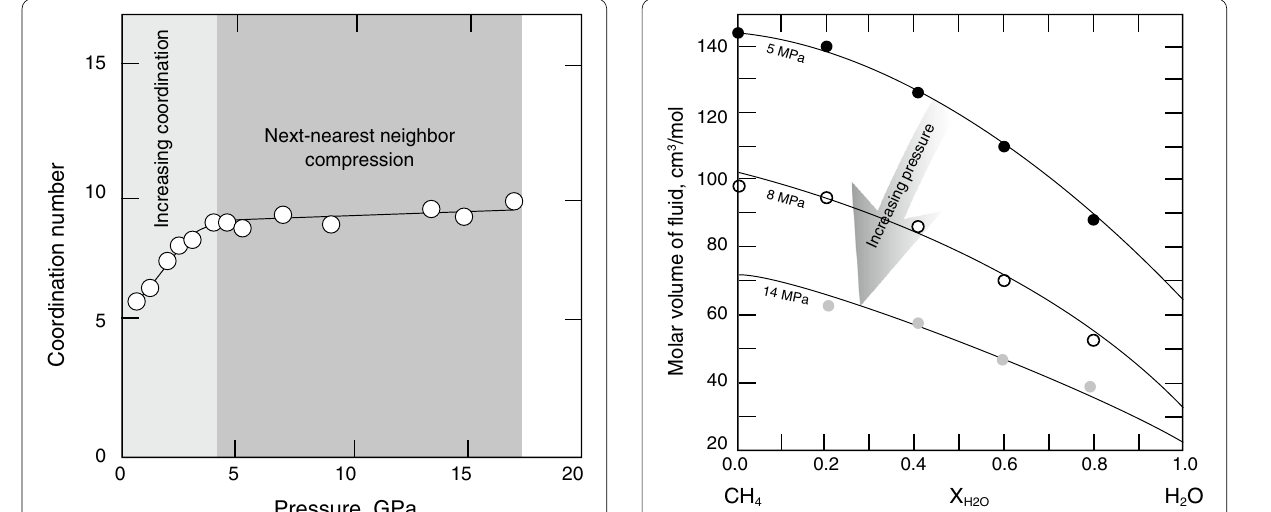
Fig. 32 Molar volumes of H 2 O–CH 4 fluids as a function of H 2 O/CH 4 ratio at 400 °C and pressures indicated on curves from experiments by Shmonov et al. (1993) and compared with calculated molar volumes by Zhang et al. (2007). Lines are results from Zhang et al. (2007), whereas data points from experiments by Shmonov et al. (1993). Modified from Zhang et al.